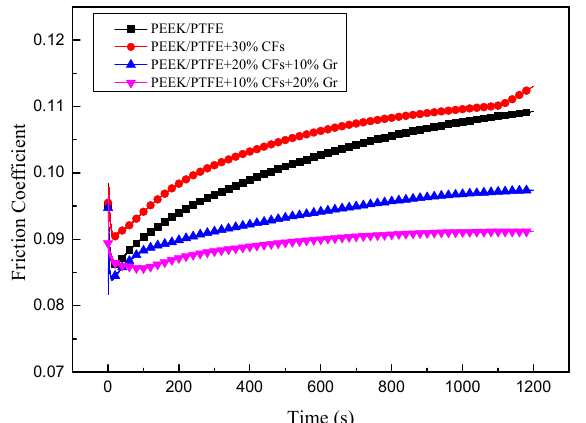
Figure 2. Friction coefficients of PEEK/PTFE composites reinforced with different contents of CFs and Gr.